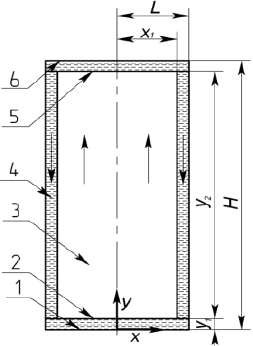
Figure 1 . Chart of the closed thermosyphon. 1 – bottom cover; 2 – surface of evaporation; 3 – vapor; 4 – film of liquid; 5 – surface of condensation; 6 – upper